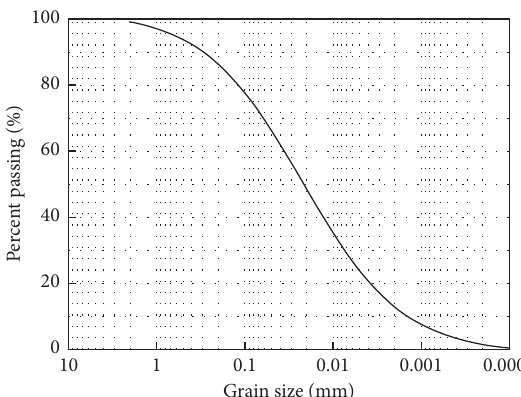
Figure 4: Grain size